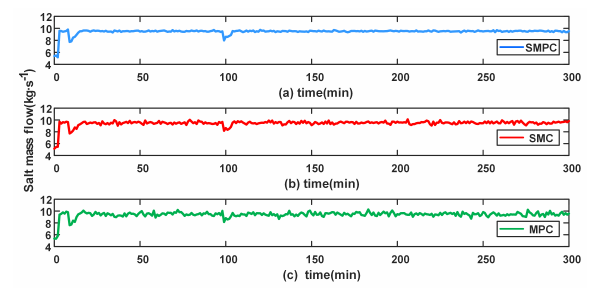
Fig. 7. Collector field outlet temperature under SMPC.